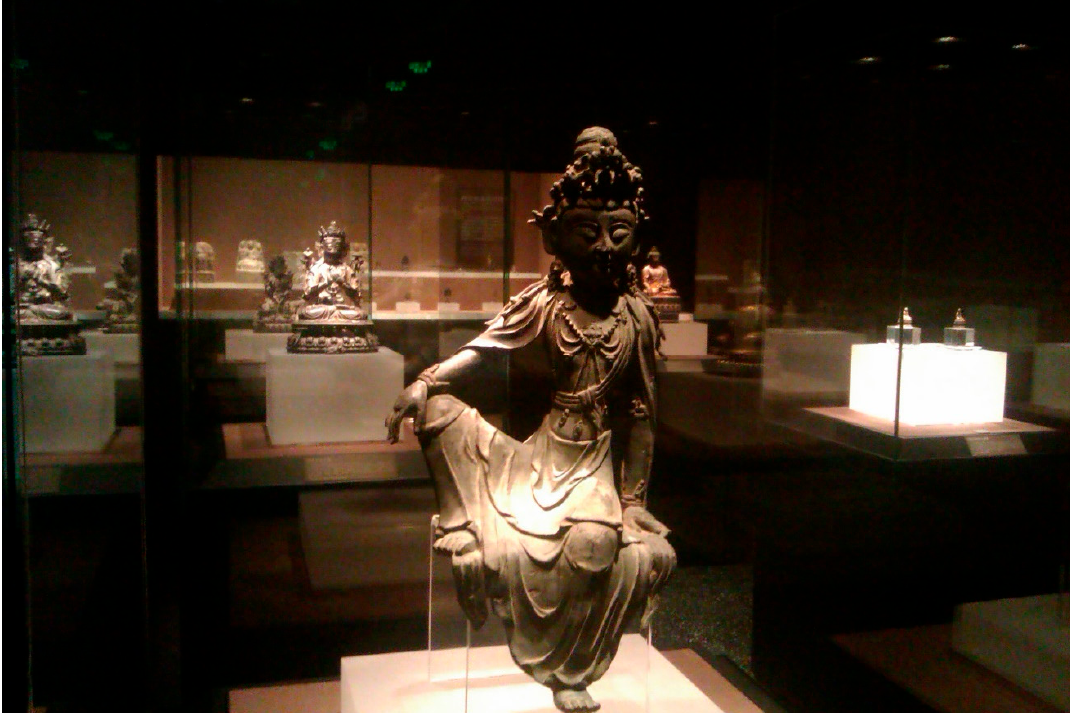
Figure 13. Bodhisattva on display in the “Selected Works of Ancient Buddhist Statues” Gallery, Capital Museum, Beijing (photo L. Tythacott 2014).